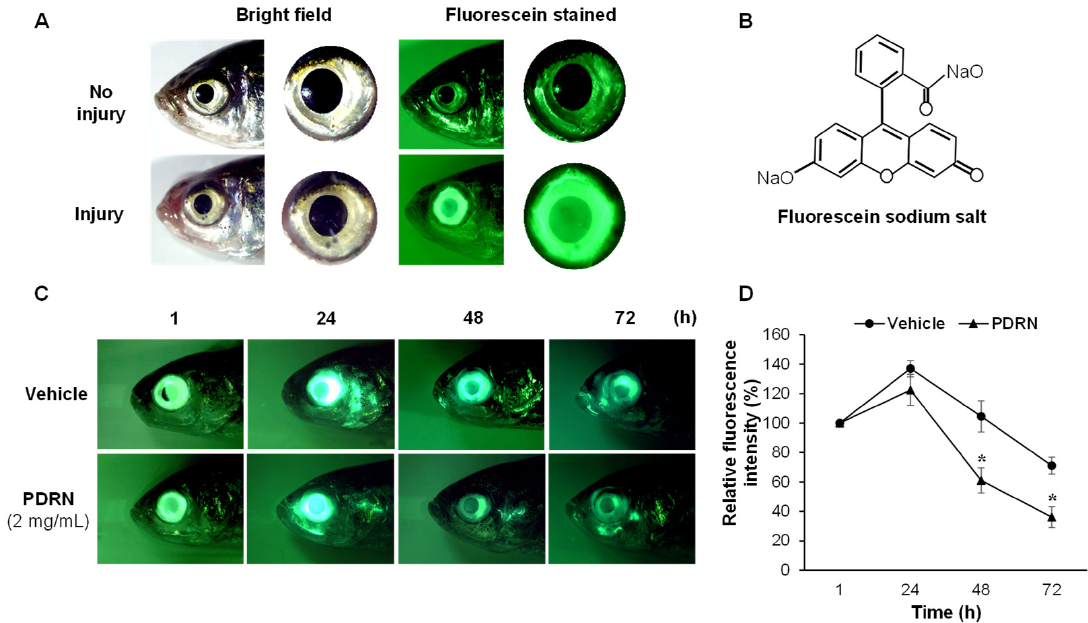
Figure 2. Examination of PDRN effect on corneal re-epithelialization upon acetic acid injury. ( A ) The representative photographs of fluorescein-stained zebrafish eye of the control and the acid injury groups. ( B ) The chemical structure of fluorescein sodium salt. ( C ) The time-dependent fluorescence intensity change at the injury site of the eye and ( D ) quantification of the relative fluorescence intensity of cornea-injured PDRN- and vehicle-treated groups. Data are presented as the mean ± standard deviation (SD). Student’s two-tailed t -test was performed to find statistical significance, * p < 0.05 for the PDRN group vs. the vehicle group ( n = 16).